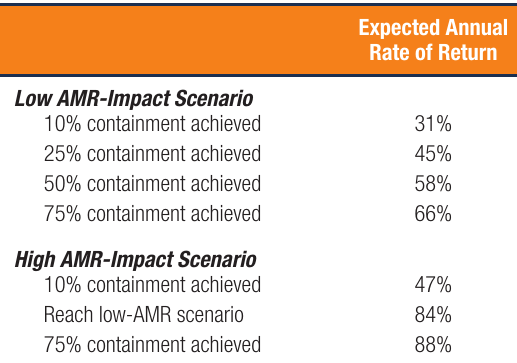
TABLE 3. Sensitivity of Expected Rate of Return to AMR Containment Success (Assuming $9 Billion Annual Investment in AMR